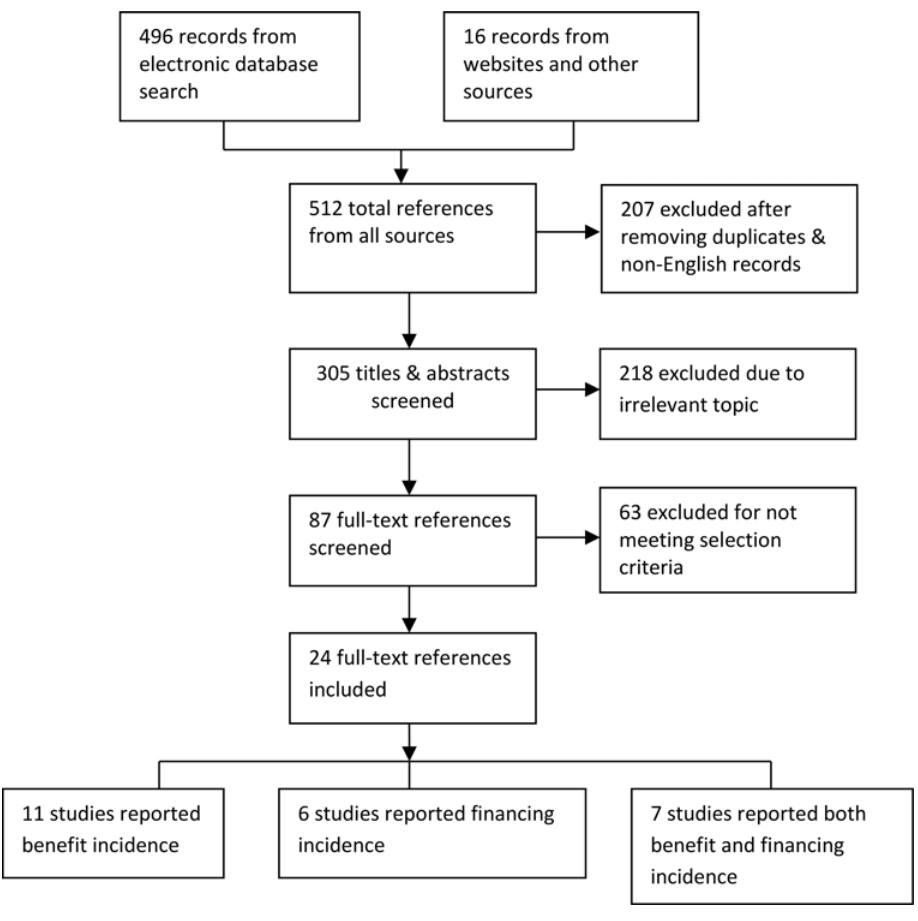
Fig 1. PRISMA Flow Diagram for Selection of